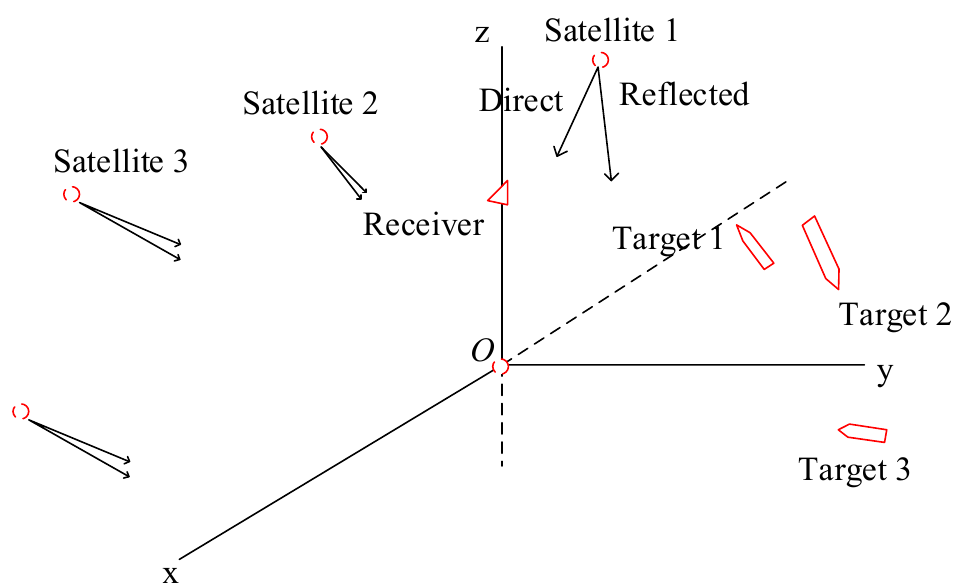
Figure 1. MIMO and multiple target BDS signal detection geometric model.